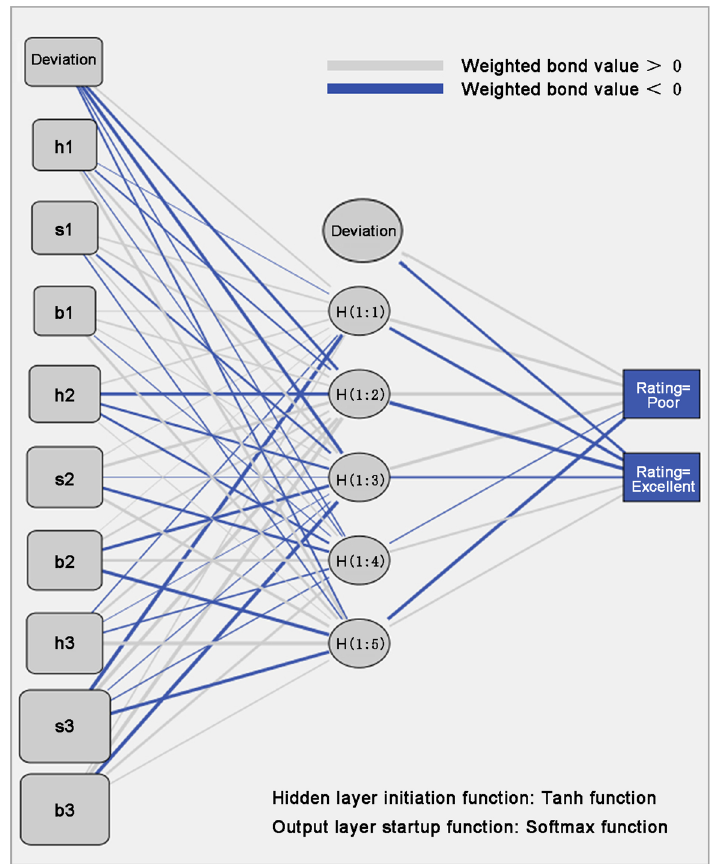
Figure 3. Network structure of the completed training child shopping cart product color decision model.